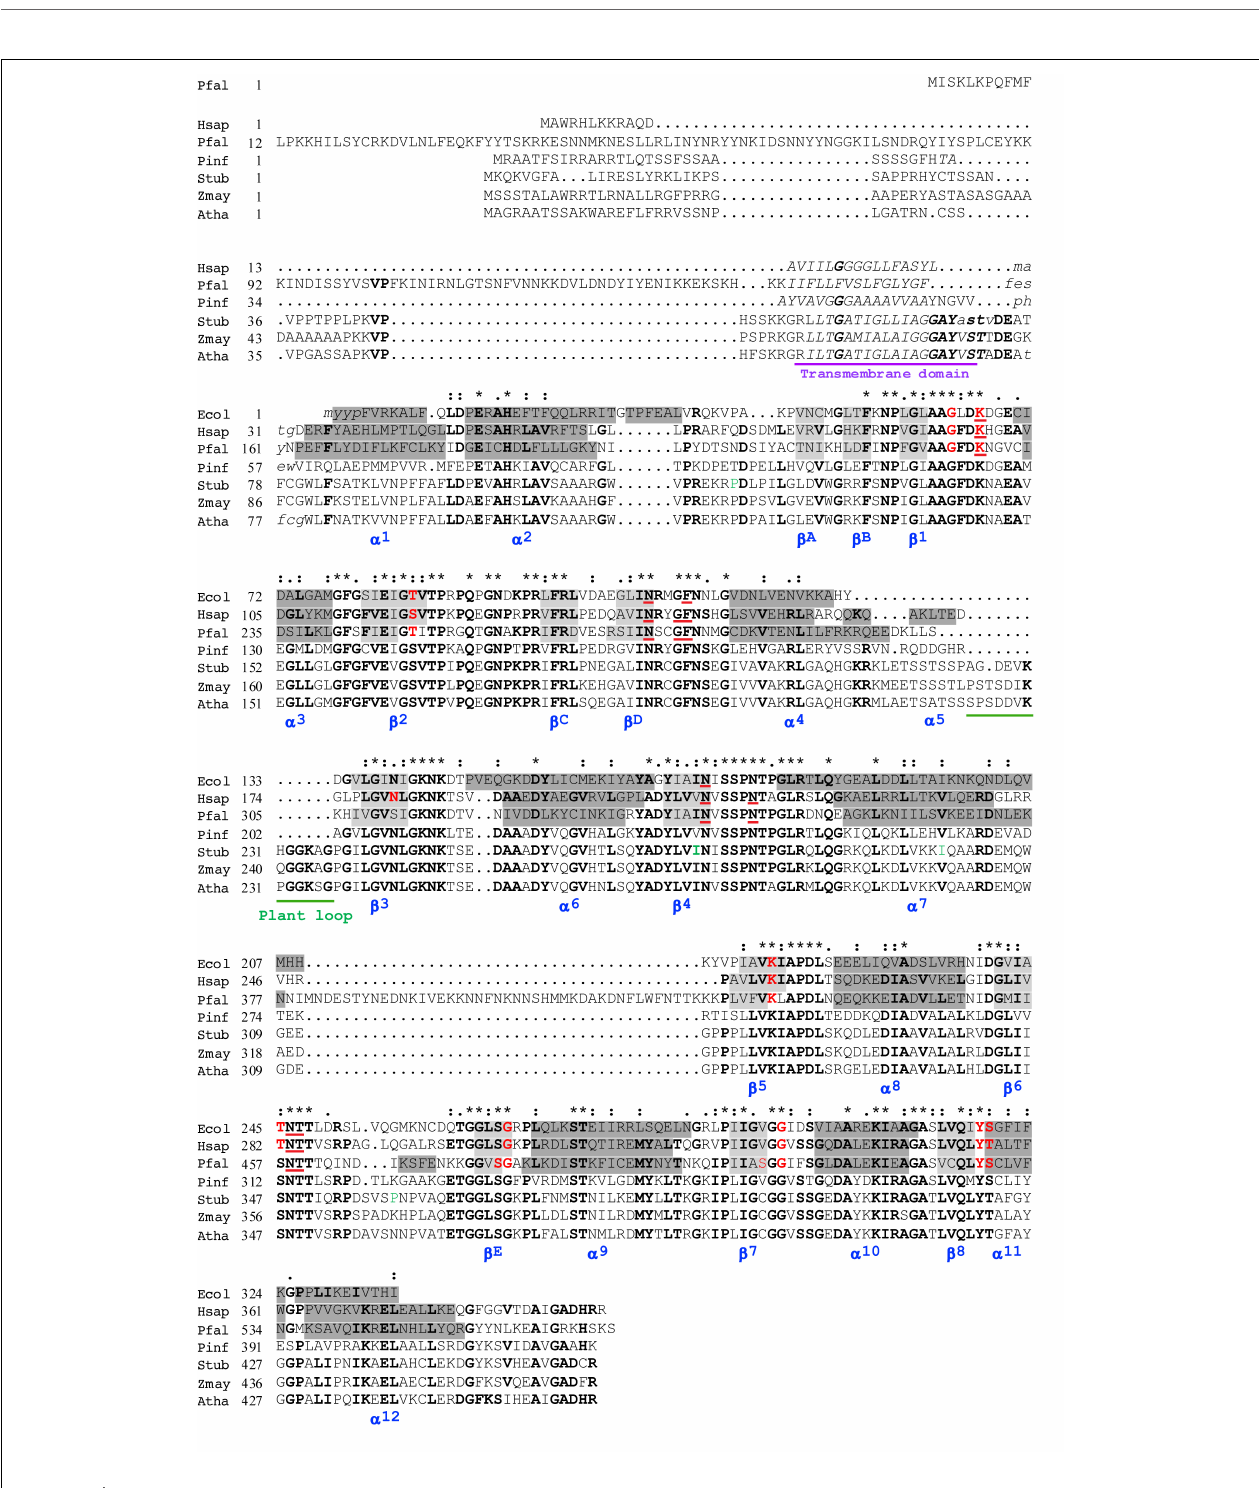
FIGURE 1 | Alignment of the predicted amino acid sequences of Phytophthora infestans and Solanum tuberosum DHODHs with other class 2 DHODHs. Selected class 2 DHODHs were aligned according to sequences and 3D-structures of human, 1D3H (Liu et al., 2000), P. falciparum , 1TV5 (Hurt et al., 2006), and E. coli , 1F76 (Nørager et al., 2002) DHODHs. Secondary structures are named (blue) according to Liu and co-workers, where alpha helices are highlighted in dark gray, and beta sheets in light gray (Liu et al., 2000). The transmembrane domain is underlined in purple, and a sequence found only in plants is underlined in green. In the human DHODH sequence, residues interacting with FMN are shown in red, and residues interacting with orotate are underlined in red (Liu et al., 2000). Conserved residues are indicated with asterisks, conservative substitutions with colons, and semiconservative substitutions with periods, above the sequences. Residues in bold are conserved in more than 55% of the sequences. Four residues (P120T, I273V, I299V, and P359Q), shown in green, indicate positions where the published StDHODH sequence (PGSC0003DMG401016396) differs from the sequence of (cid:49) N69StDHODH (P120T, I273V, I299V, and P359Q). Ecol, E. coli , 1F76 – WP_001295934; Hsap, Homo sapiens , 1D3G – NP_001352; Pfal, P. falciparum , 1TV5 – XP_966023; Pinf, P. infestans , PITG_01913; Stub, S. tuberosum , PGSC0003DMG401016396; Zmay, Zea mays , NP_001152058; Atha, A. thaliana , AAN64025. Frontiers in Microbiology |